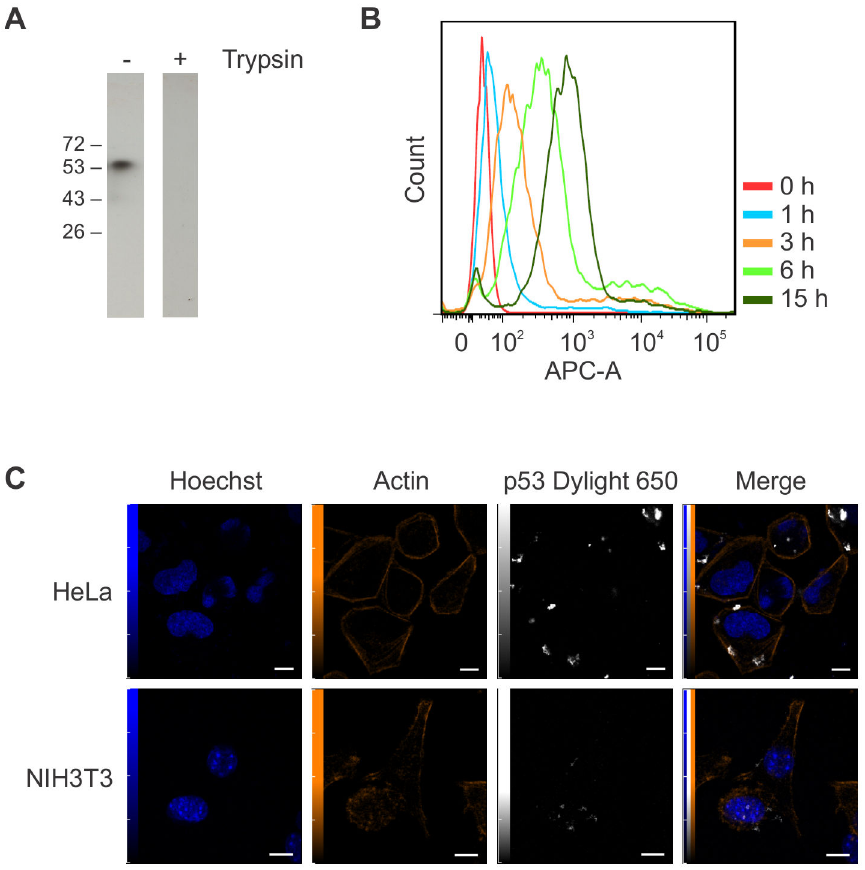
Figure 2. p53 aggregates are internalized by HeLa and NIH3T3 cells. (A) Aggregated p53 was treated with trypsin for 5 min, resolved by 10% SDS-PAGE and analysed by Western Blot. (B) HeLa cells were incubated with 1 µM DyLight 650-conjugated p53 aggregates for 24 h and analysed by flow cytometry. (C) HeLa and NIH3T3 were incubated with 1 µM DyLight 650-conjugated p53 aggregates for 24 h and visualized by confocal microscopy. Scale bars: 5